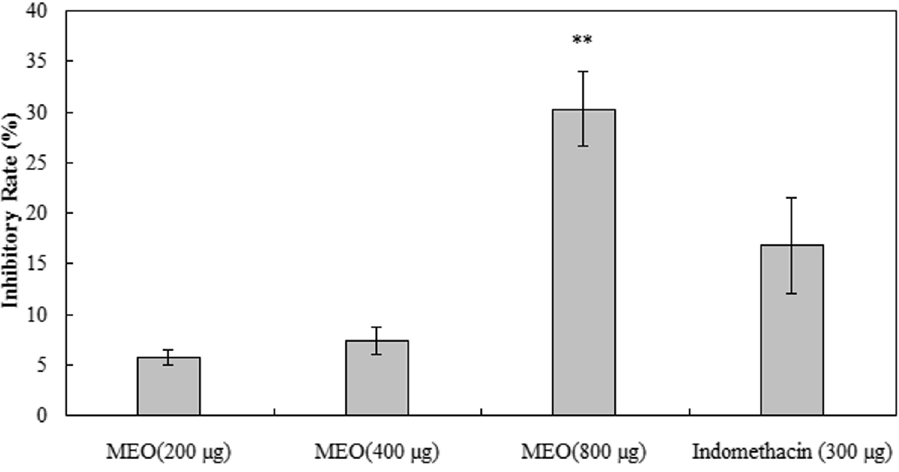
Fig. 2. The effect of MEO against croton oil-induced ear edema in mice. Data are representative of ten experiments and as means ¡ SE. Indomethacin was used as a reference compound (300 m g per ear). Statistical differences from indomethacin-treated control as analyzed by Dunnett’s test (** P ,